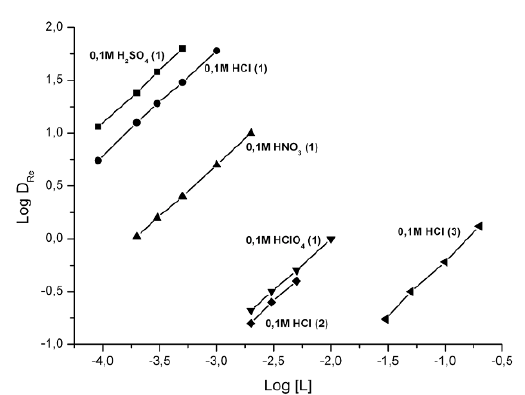
Figure 9. The effect of the concentration of extractants 1-3